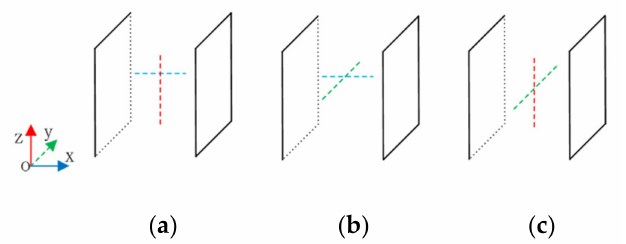
Figure 5. Three cases of intersection of two line- segments in Slist and Tlist. ( a ) The intersection plane is parallel to xoz . ( b ) The intersection plane is parallel to xoy . ( c ) The intersection plane is parallel to yoz .